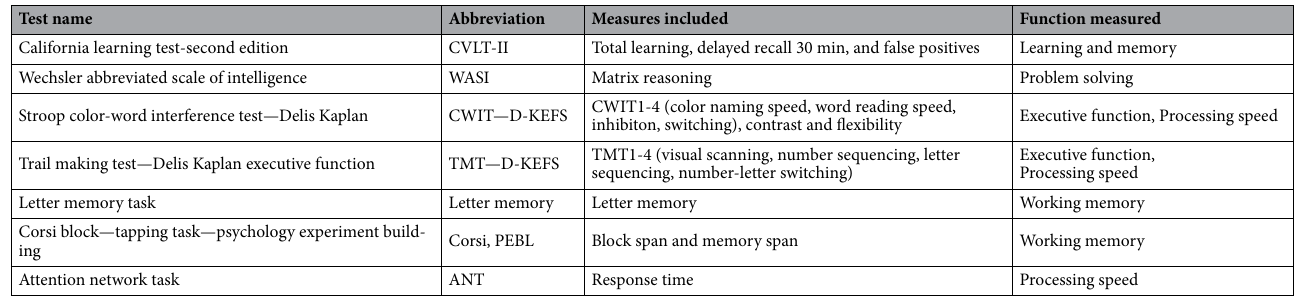
Table 1. Tests used for cognitive assessment and what functions they